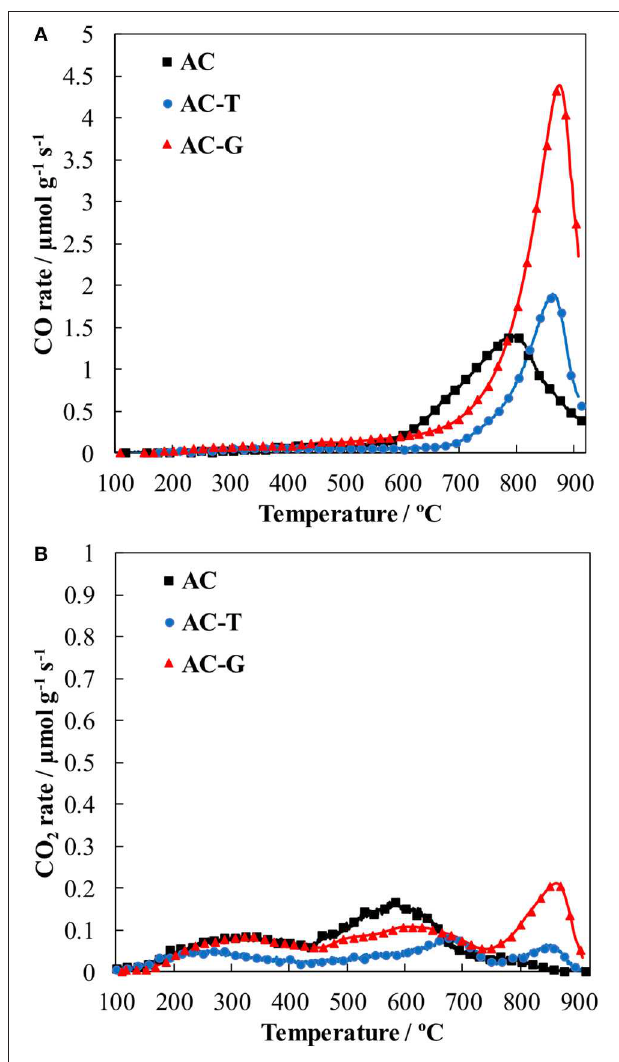
FIGURE 4 | CO (A) and CO 2 (B) TPD evolution profiles of the prepared activated carbons.